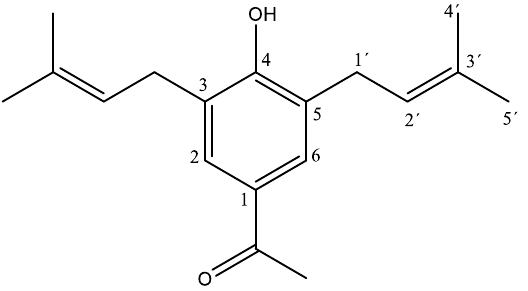
Figure 1. DHAP chemical structure.